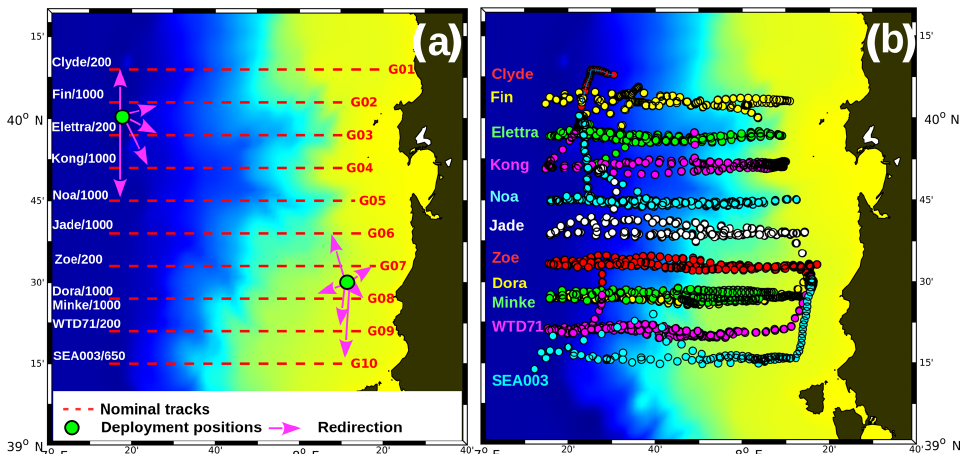
Figure 7. (a) Nominal tracks and deployment positions of all gliders launched during Leg 1. The names of the gliders are written at the western end of their respective tracks, and the number behind the name stands for the pressure rating in dbar. The gliders are redirected from the deployment positions to their nominal tracks. (b) Real tracks of all gliders for 8–23 June. The circles indicate the surfacing positions. The colour code for the water depth is the same as in Fig. 2.